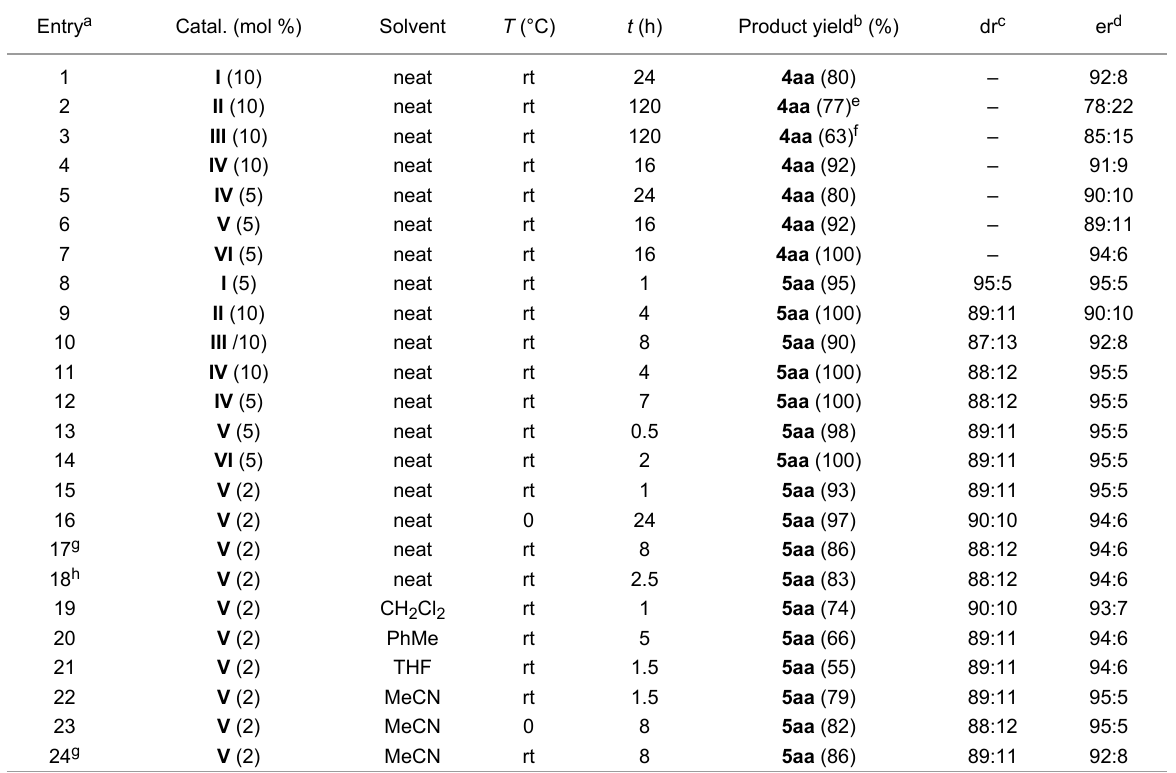
Table 1: Screening of catalysts and optimization of the reaction conditions for the additions of diethyl malonate and ethyl 2-oxocyclopentanecarboxy- late to β -nitrostyrene.